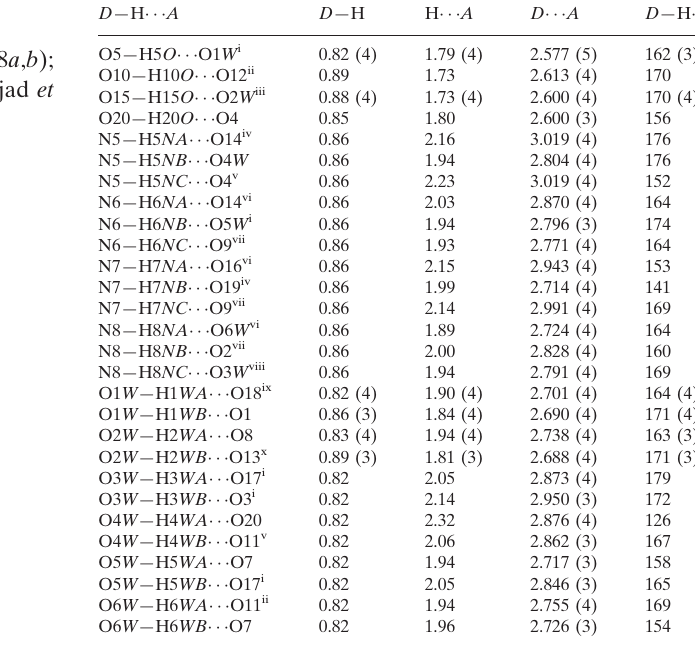
The asymmetric unit of the title compound, (C H N )- 3 12 2 H NO ) ] (cid:2) 3.5H O, contains two formula units. The [Zn(C Selected bond lengths (A˚ ). 7 3 5 2 2 compound consists of an anionic complex, a doubly proto- nated propane-1,3-diamine as a counter-ion and 3.5 uncoord- inated water molecules. The coordination polyhedron around the Zn II atom is distorted octahedral, defined by four O atoms chel = 4-hydroxy- and two N atoms from two Hchel (H 3 pyridine-2,6-dicarboxylic acid) ligands. In the crystal structure, O—H (cid:2) (cid:2) (cid:2) O, N—H (cid:2) (cid:2) (cid:2) O and C—H (cid:2) (cid:2) (cid:2) O hydrogen bonds along with (cid:3) – (cid:3) stacking interactions [centroid–centroid distance = 3.473 (2) A˚ ] are observed to reinforce the crystal cohesion. Hydrogen-bond geometry (A˚ , (cid:3) Related literature